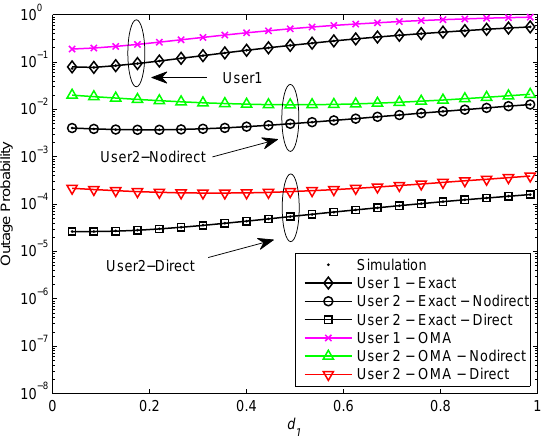
Figure 5. Outage probability versus normalized distance between BS and U 1 ( ρ = 30 dB).